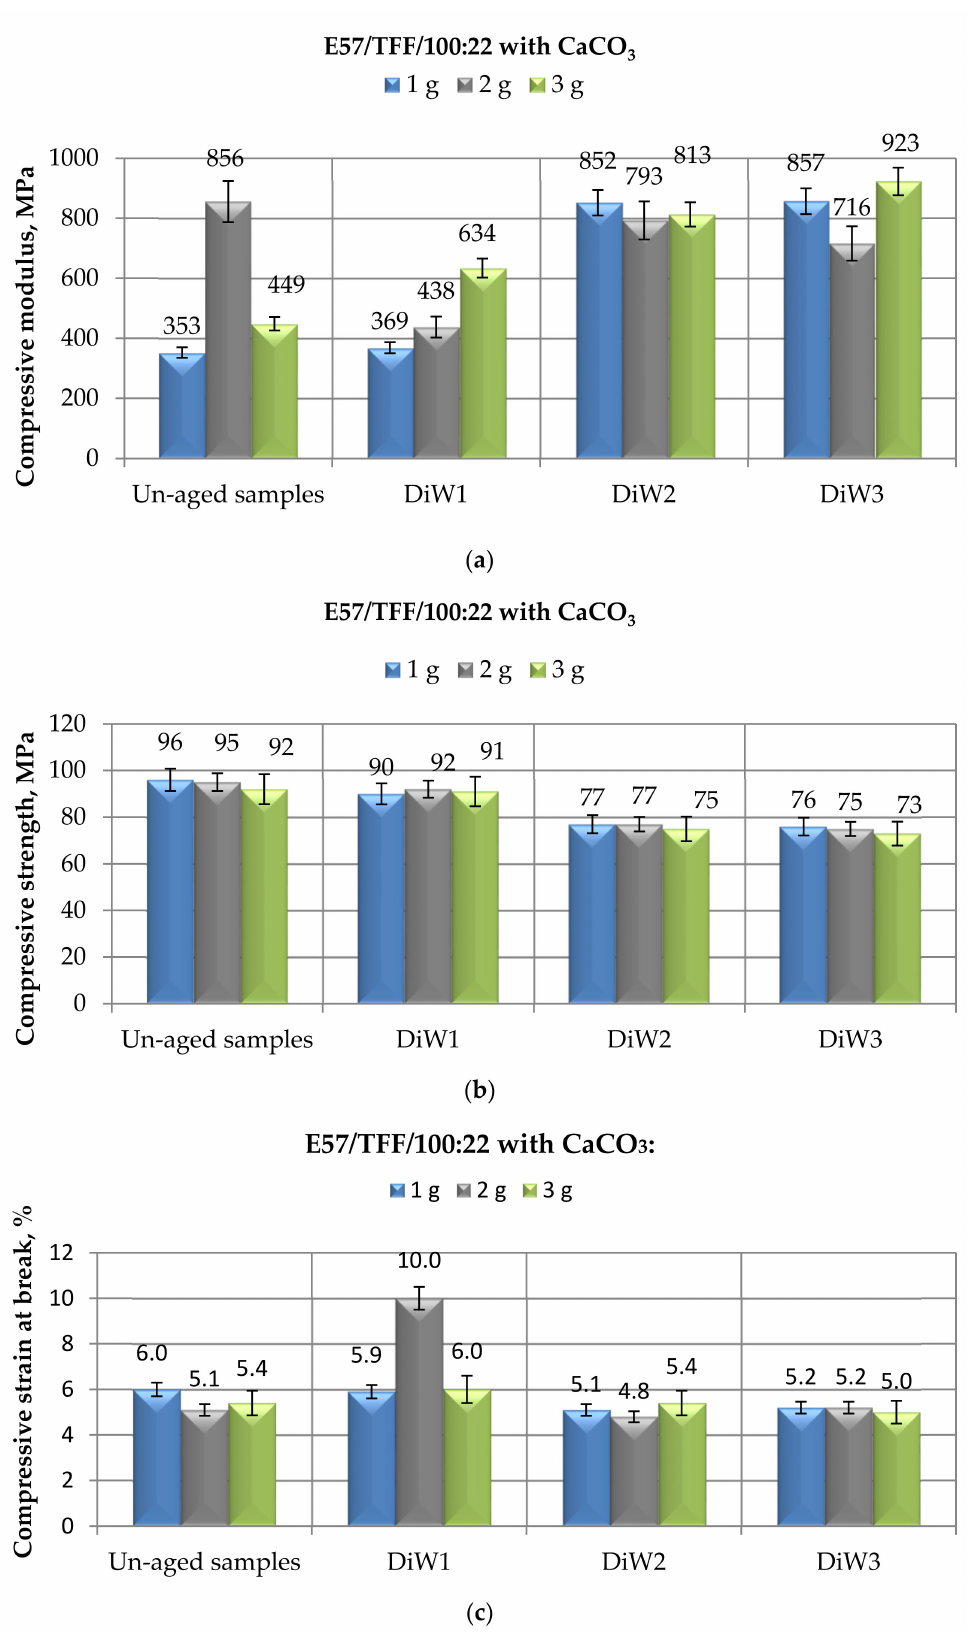
Figure 4. Results of mechanical tests performed in compression mode on CaCO 3 -filled E57/TFF/100:22 specimens after different immersion times (i.e., 1, 6, and 10 months) in distilled water, in terms of ( a ) Compressive modulus; ( b ) Compressive maximum strength; ( c ) Compressive strain at